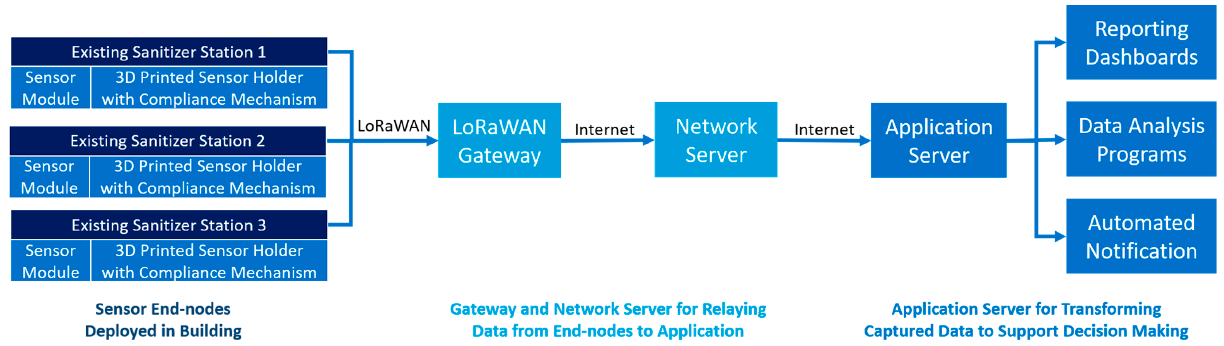
Figure 2. Block diagram of Sanitizer Dispenser Network system design.